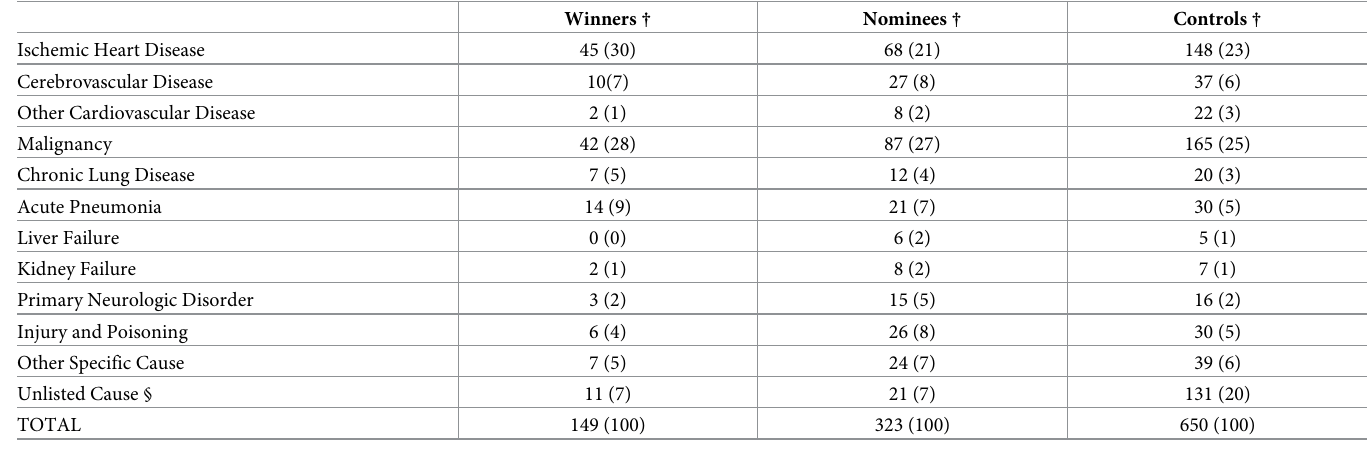
Table 2. Causes of death �